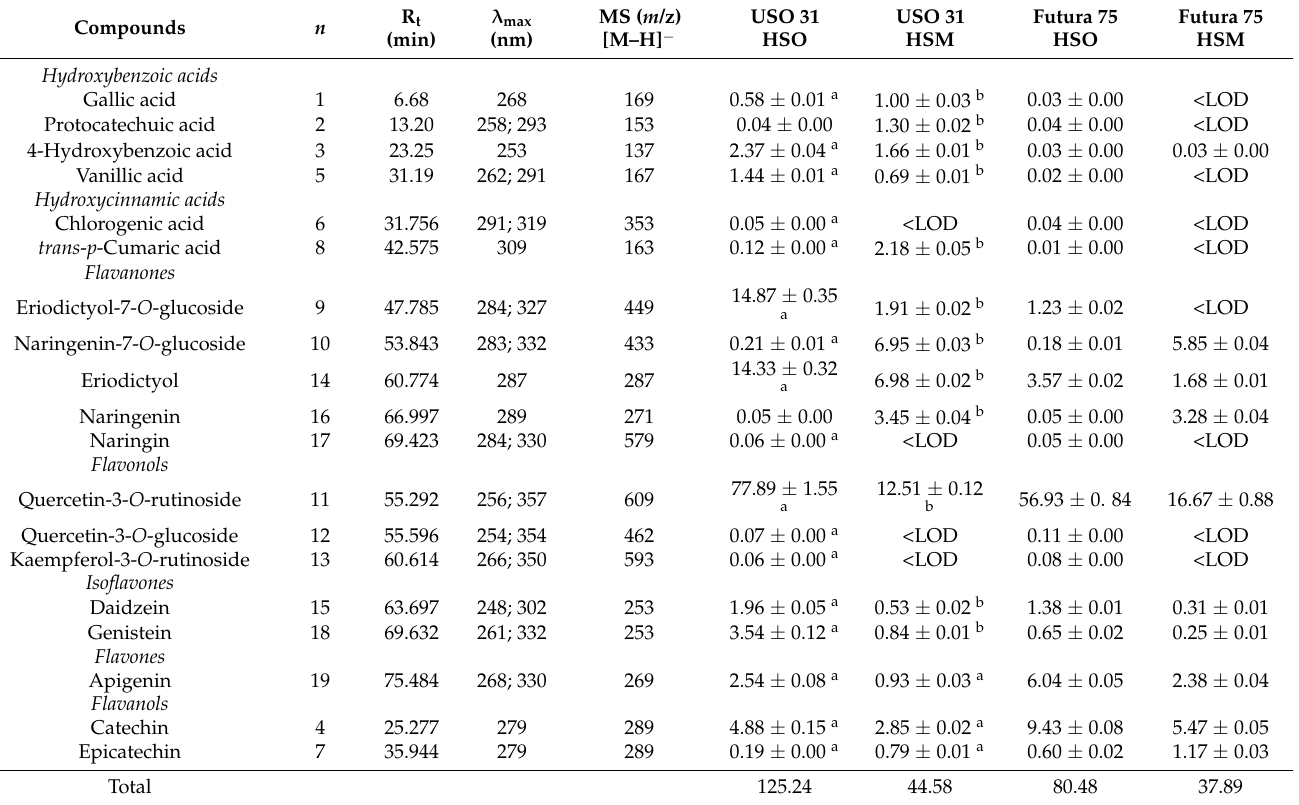
Table 3. Qualitative and quantitative characterization of polyphenols in methanol extract of USO 31 and Futura 75 hempseed oil (HSO) and their processing byproducts (hempseed meal, HSM) by LC-DAD-ESI-MS analysis. Data, which are the mean ± standard deviations (SD) of three independent experiments ( n = 3), were expressed as µ g/100 g of fresh weight